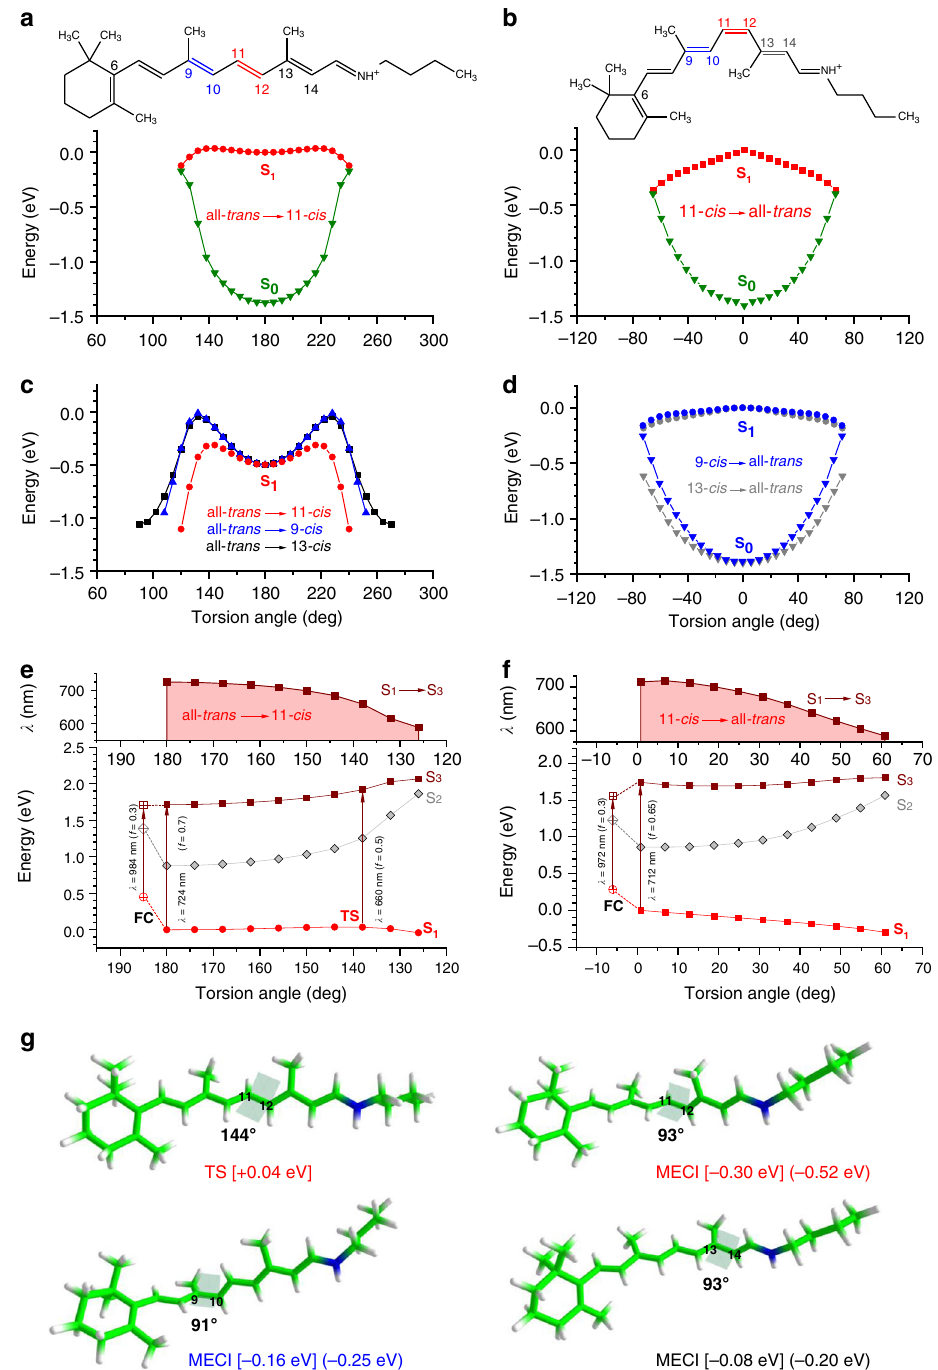
Fig. 4 Calculated potential-energy curves along the isomerization coordinates in all- trans , 11- cis , 9- cis , and 13- cis retinal protonated Schiff-base (RPSB). a – d Excited-state relaxed geometry scans for rotation about double bonds are shown in red ( ∠ C 10 C 11 = C 12 C 13 ), blue ( ∠ C 8 C 9 = C 10 C 11 ), and black ( ∠ C 12 C 13 = C 14 C 15 ). Ground-state energies calculated at the S 1 optimized geometries along the lowest-energy pathway are shown in green. The planar structures in S 1 are obtained through the unconstrained optimization for all isomers, except for the 11- cis isomer, where the torsion angle is kept fi xed. Note that the 6s- cis and 6s- trans rotomers are found to have the same barrier heights that hinder isomerization in S 1 in all- trans RPSB (see Supplementary Figure 4). e , f Transient absorption calculated as vertical excitation energies S 1 – S 3 in all- trans and 11- cis RPSB. Oscillator strengths f along the reaction pathways are shown in brackets. Note that the S 1 – S 2 transition has a lower oscillator strength of <0.1 and gains some intensity ( f = 0.2) through mixing with the S 3 state near the Franck – Condon (FC) point and closer to the S 1 /S 0 conical intersections. g Optimized structures of the lowest-energy transition state in S 1 in all- trans RPSB (TS) and the minimum-energy conical intersections S 1 /S 0 (MECI). Carbon atoms are depicted in green, hydrogen atoms in white, and the nitrogen atom in blue. Energies in square and round brackets are shown with respect to the all- trans and the corresponding single cis RPSB planar structures in S 1 ,